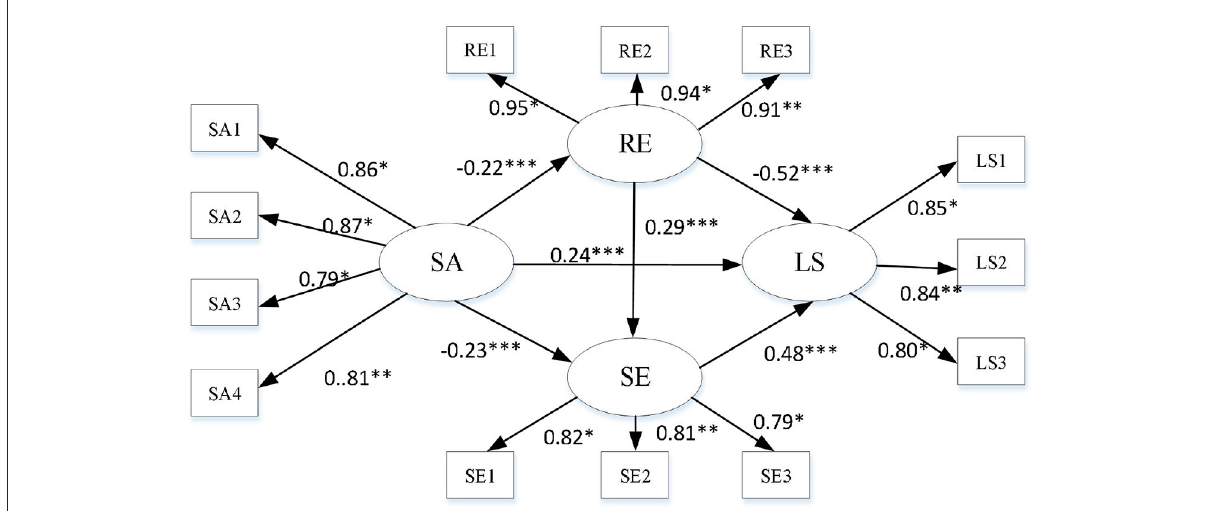
FIGURE2 A chain mediating model of subjective age predicting the loneliness in the old adults. SA, subject age; LS, loneliness; RE, resilience; SE, self-esteem. * p < 0.05; ** p < 0.01; *** p <